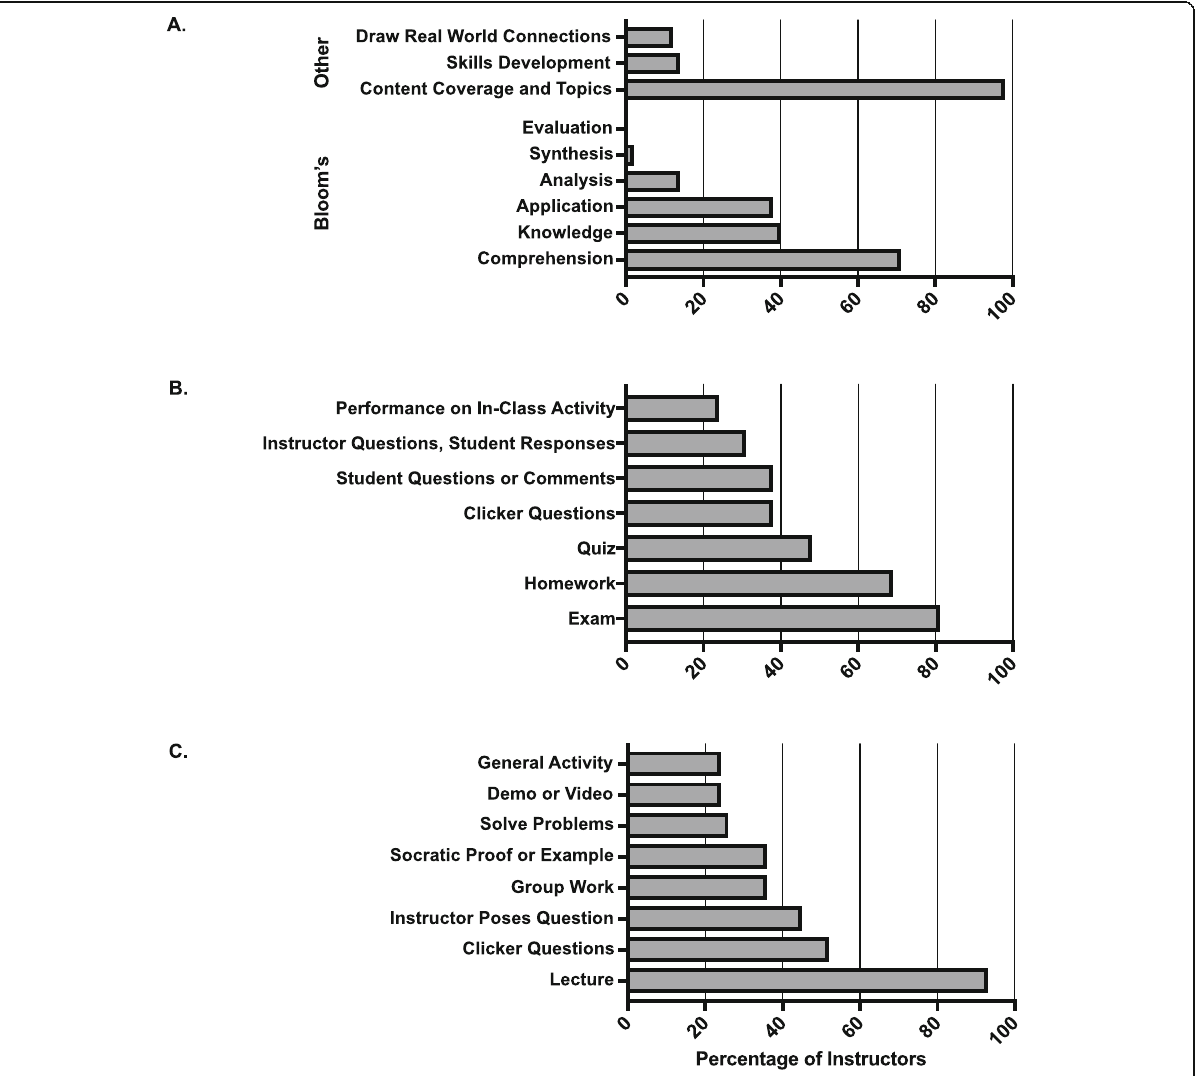
Fig. 1 Instructor descriptions of the planning process. Codes that emerged from participants ’ answers to questions 3 – 4 in the pre-interview. a Learning goals. b Assessment strategies. c Engagement strategies. The frequencies reflect the number of participants whose responses were coded for the code in question at least once, as opposed to the total number of statements reflecting the